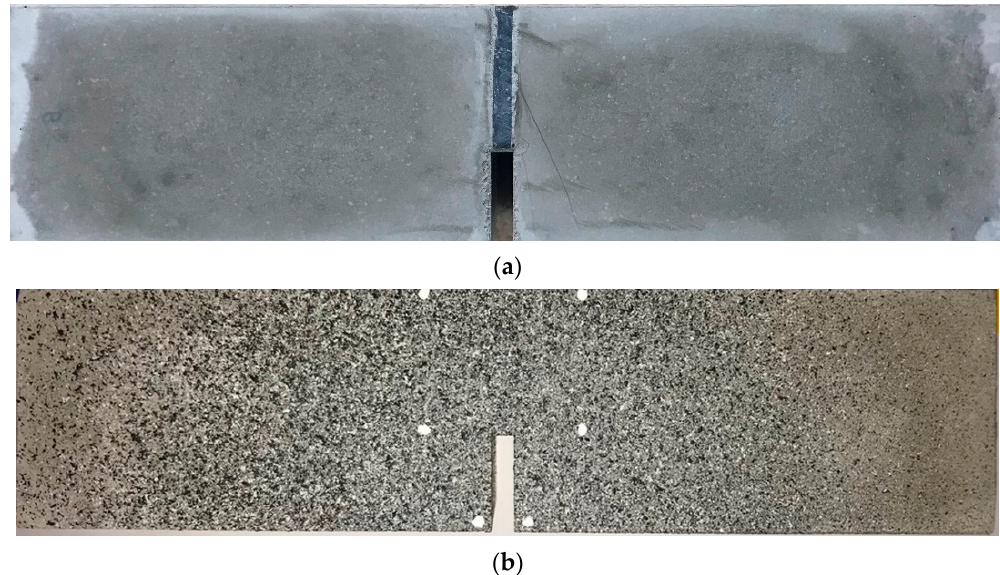
Figure 4. Specimen preparation for the digital image correlation (DIC) analysis [4]. ( a ) Surface of the fracture toughness test specimen; ( b ) surface of the fracture toughness test specimen with the applied